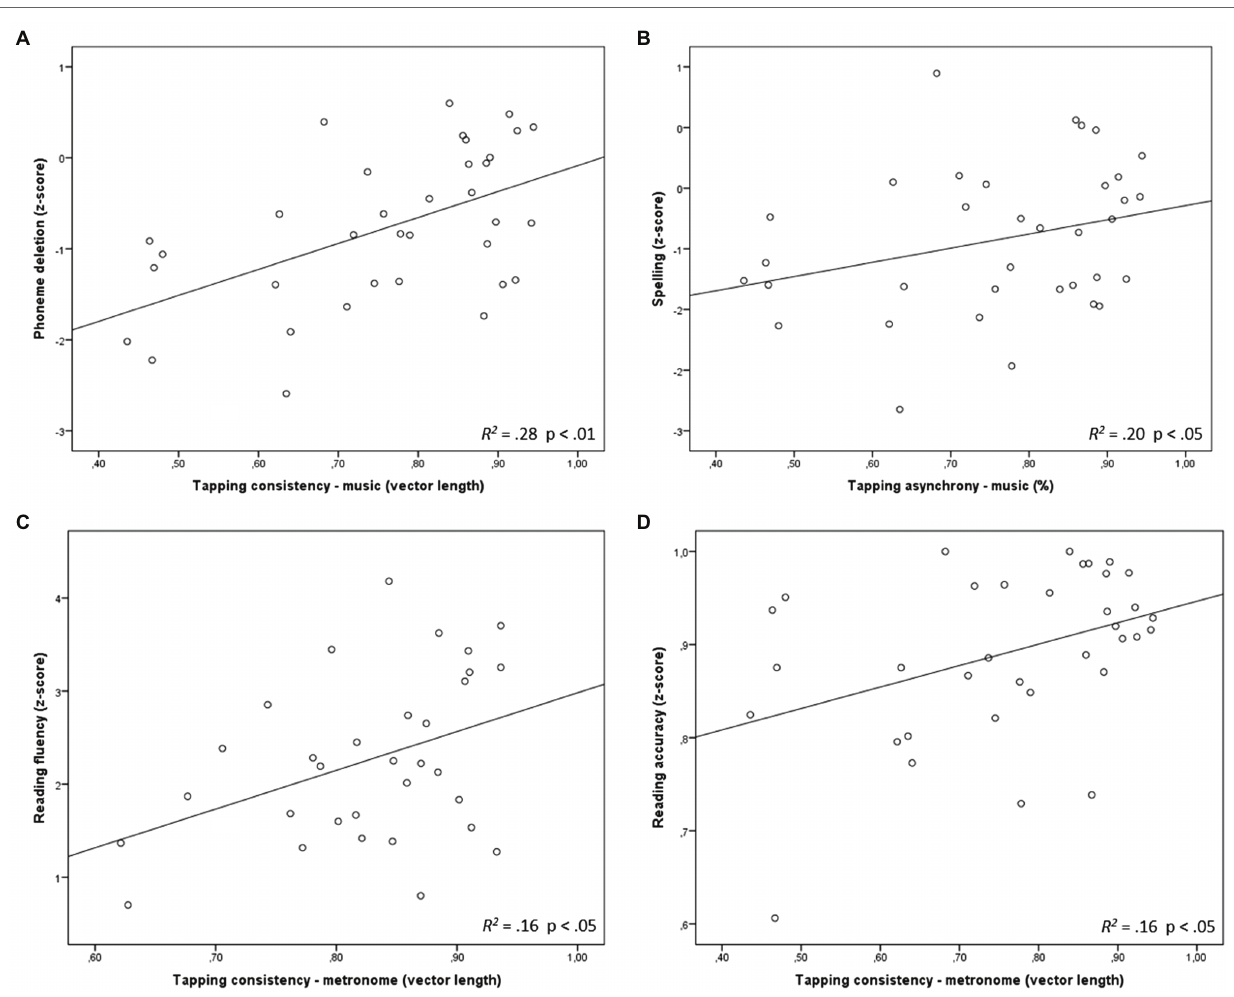
FIGURE 2 | Relation between tapping consistency in musical tasks and phoneme deletion (A) , tapping asynchrony in musical tasks and spelling (B) , tapping consistency in metronome tasks and reading fluency (C) and tapping consistency in metronome tasks and reading accuracy (D) . Consistency is given as the length of the resultant vector (see Measurements), where 1 stands for perfect consistency and 0 for inconsistency. Tapping asynchrony is given as the mean asynchrony of the taps (see Measurements), where 1 represents total synchrony and 0